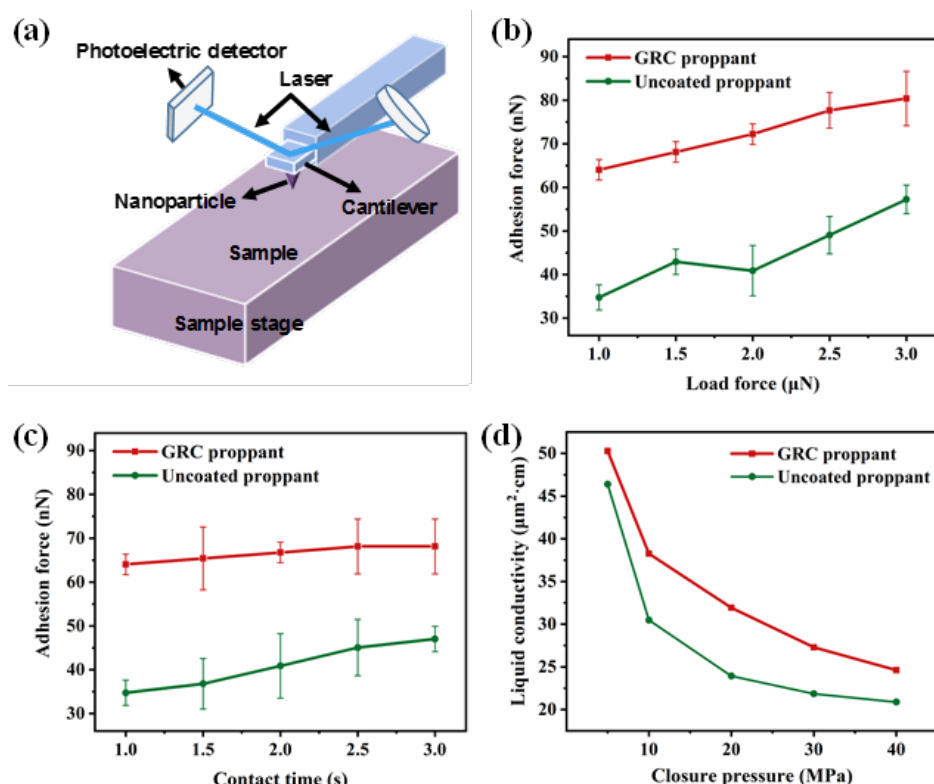
Figure 6. ( a ) Diagrammatic sketch of the adhesion force test. ( b ) Adhesion performance of the un- coated and GRC proppants at different load forces. ( c ) Adhesion performance of the uncoated and GRC proppants at different contact times. ( d ) Liquid conductivity of uncoated proppant and GRC proppants under different closure